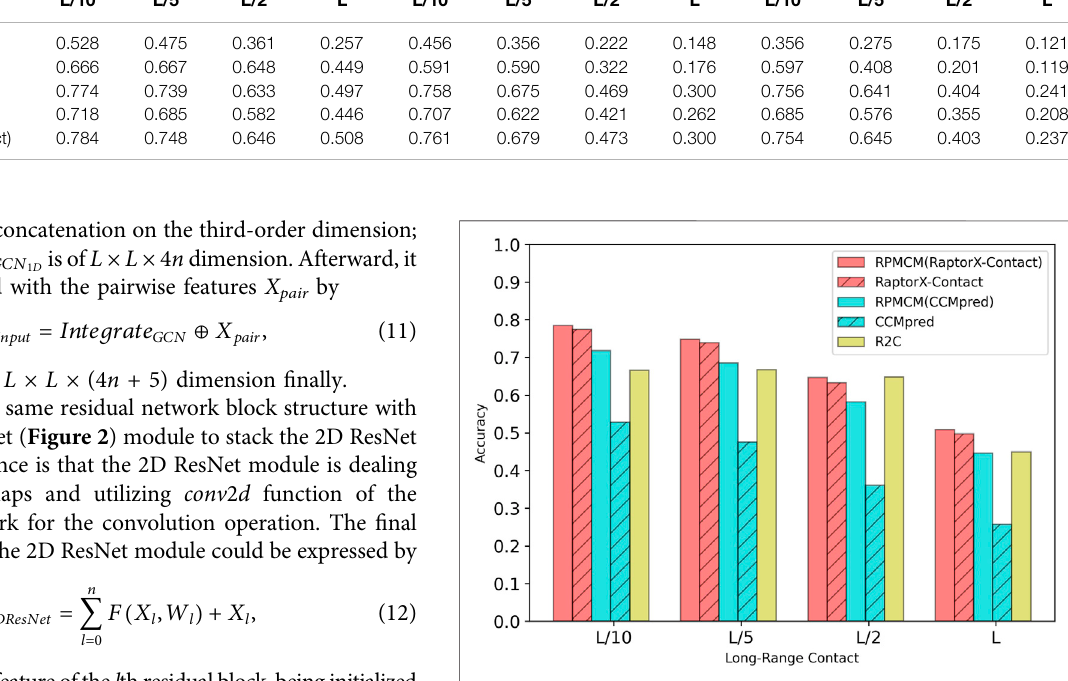
TABLE 1 | Contact map results by four different methods on the PDB25 testing dataset. Method